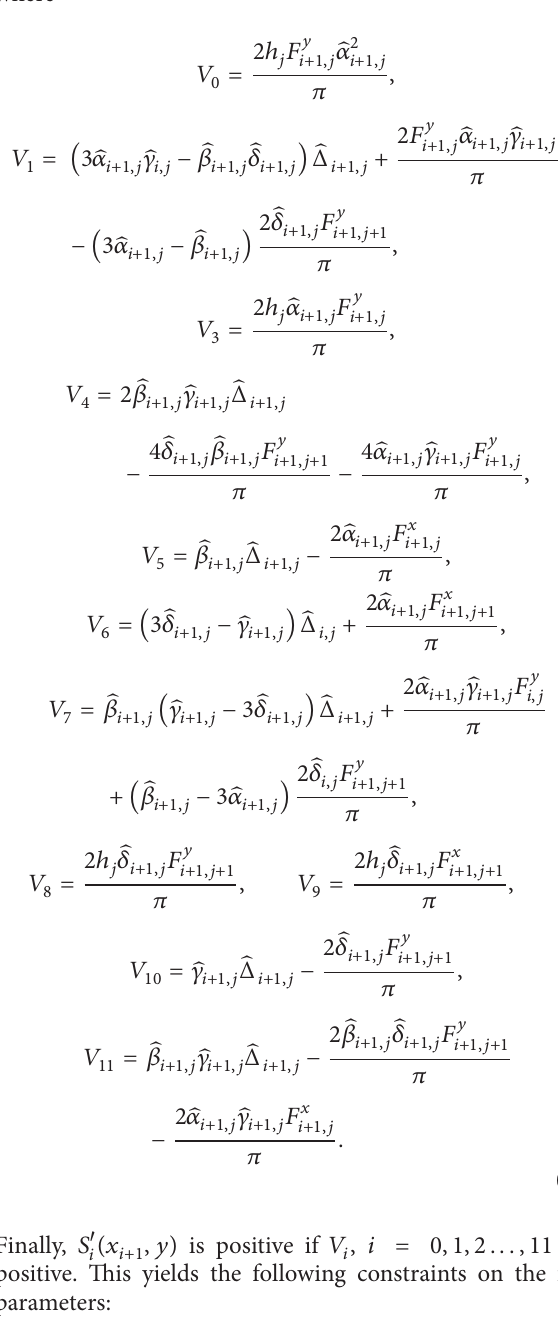
Table 1: The varying ability of hemoglobin to carry oxygen.